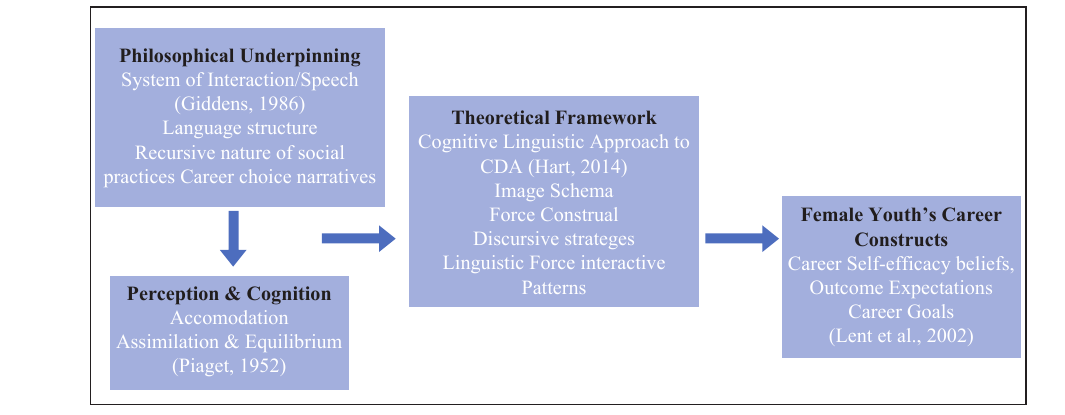
Figure 1. Research